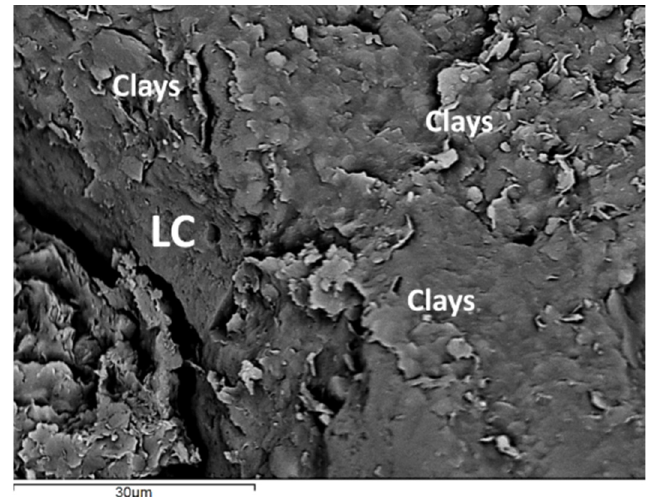
Figure 15. SE image indicating the predominant clayey cement material of KAN2-2 sample which causes its brittle behavior. Table 2. Representative micro analysis of cement in studied samples and the respect % mole Μ gC Ο 3 in calcite lattice.